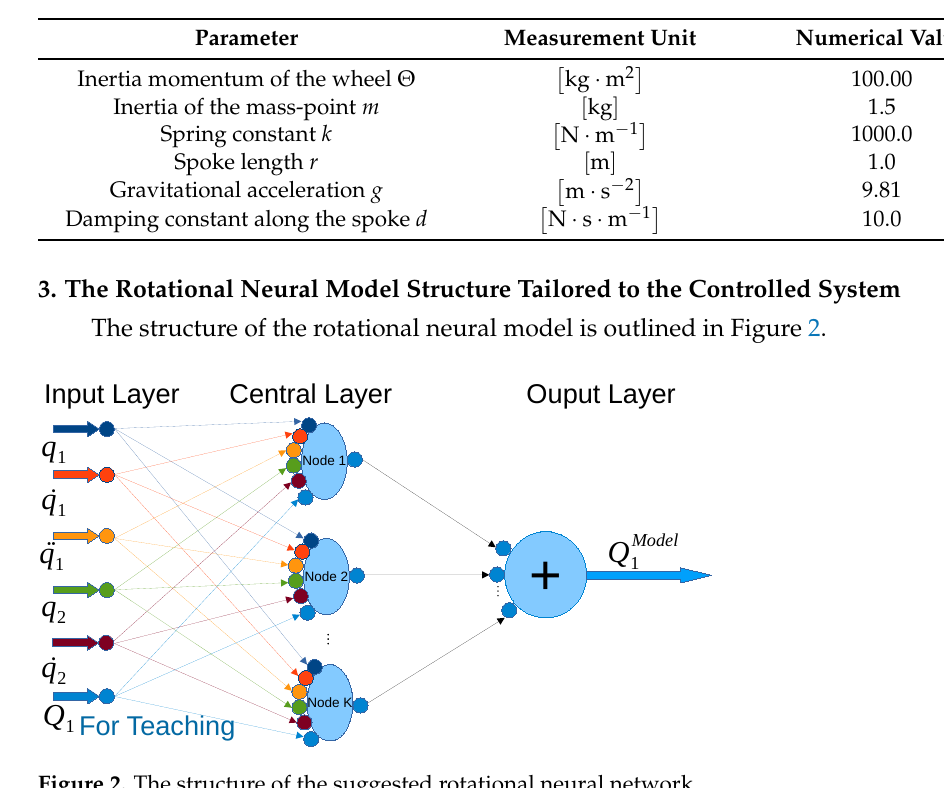
Table 1. The dynamic parameters of the controlled system.